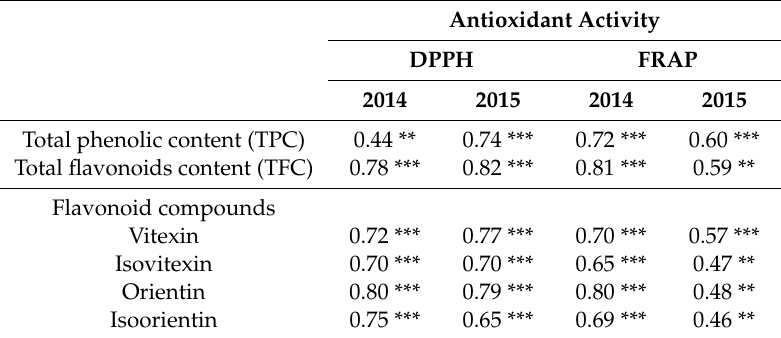
Table 3. Pearson’s correlation coe ffi cients ( r ) among antioxidant activity (estimated by DPPH and FRAP) and total phenolic content, total flavonoids content, and flavonoid compounds in fenugreek seeds in 2014 and 2015 ( n =